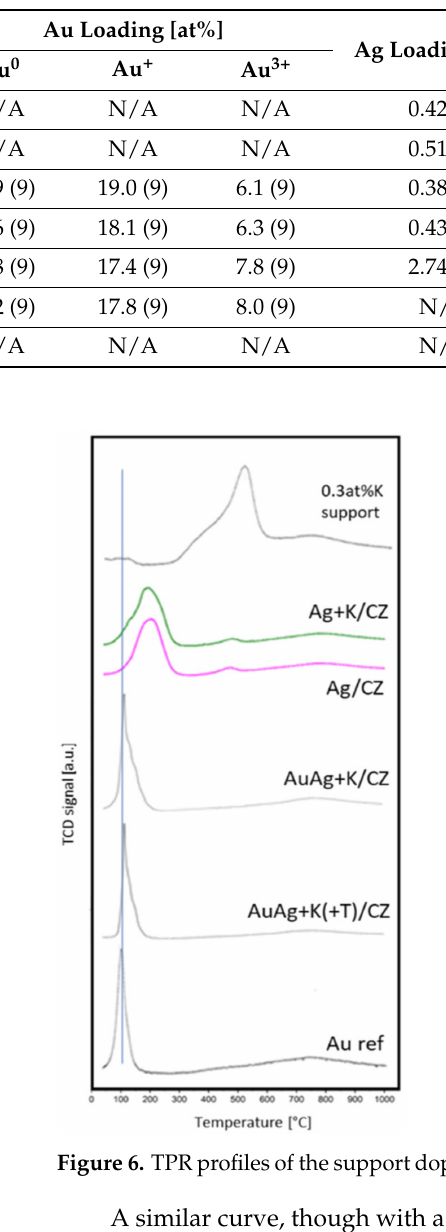
Table 2. XPS analysis of chemical states and atomic ratios on the surface of the studied catalysts. The numbers in brackets indicate the error of the measurement.